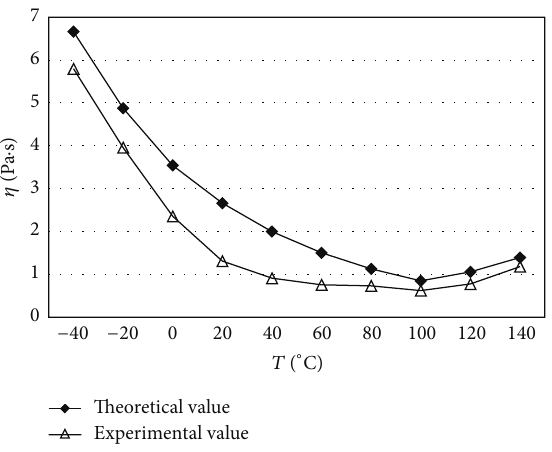
Figure 1: The curve of viscosity of MR fluid versus temperature.